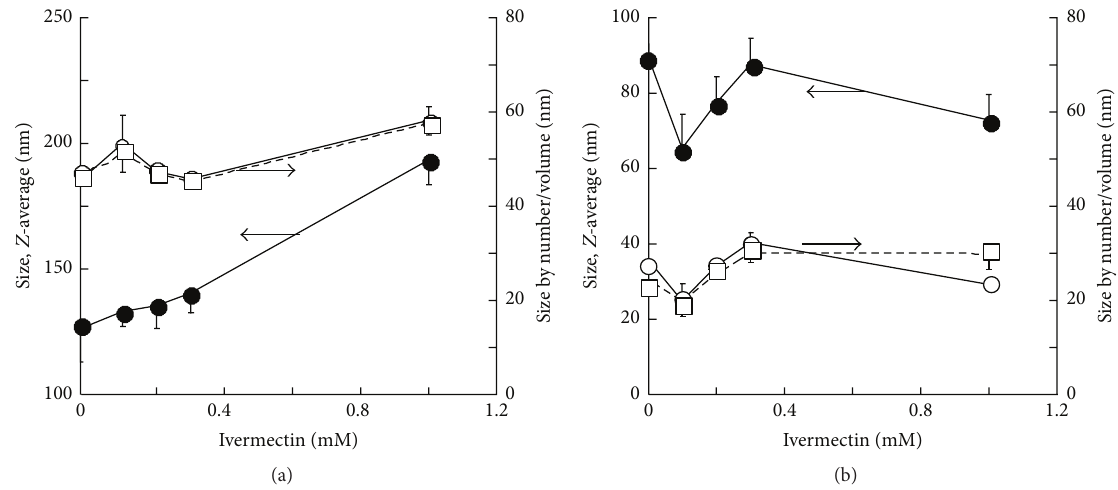
Figure 2: Effect of ivermectin content on the dimensional characteristics of different liposomal formulations (#PC9-Ch1-ive0.1, #PC9- Ch1-ive0.25, #PC9-Ch1-ive0.5, and #PC9-Ch1-ive1.0 in (a); #PC9-Br1-ive0.1, #PC9-Br1-ive0.25, #PC9-Br1-ive0.5, and #PC9-Br1-ive1.0 in (b)). Empty liposomes composed of PC/cholesterol (a) and PC/DDAB (b). Data refers to 𝑍 -average (filled circles, left 𝑦 -axis), mean by number (open squares, right 𝑦 -axis), and mean by volume (open circles, right 𝑦 -axis). The arrows indicate the 𝑦 -axis relative to the arrowed